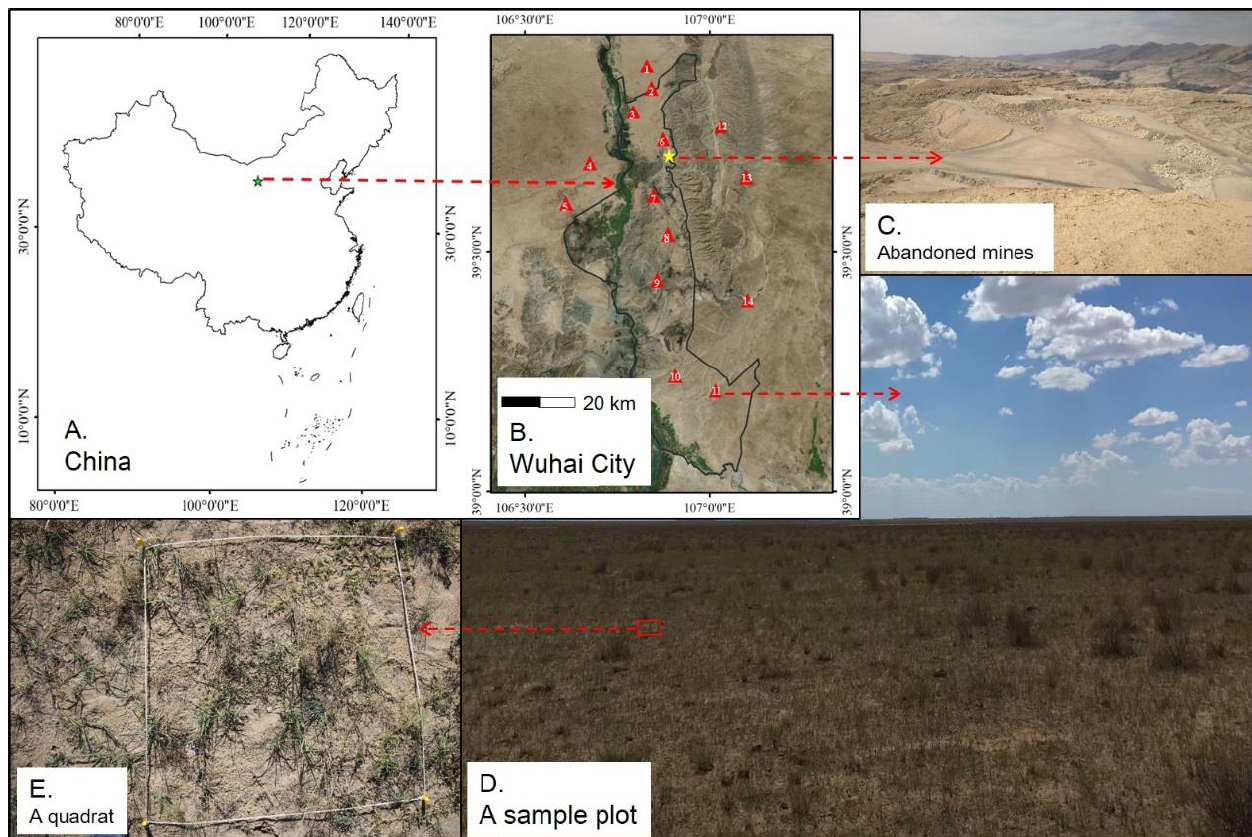
Figure 1. Research site and the plot locations of this study. ( A ): Location of Wuhai City in China; ( B ): Locations of abandoned mines and sample plots in Wuhai City; ( C ): Abandoned mines; ( D ): A sample plot in Wuhai City; ( E ): A quadrat in a sample plot. The abandoned opencast mine is located in the center of the study area (Figure